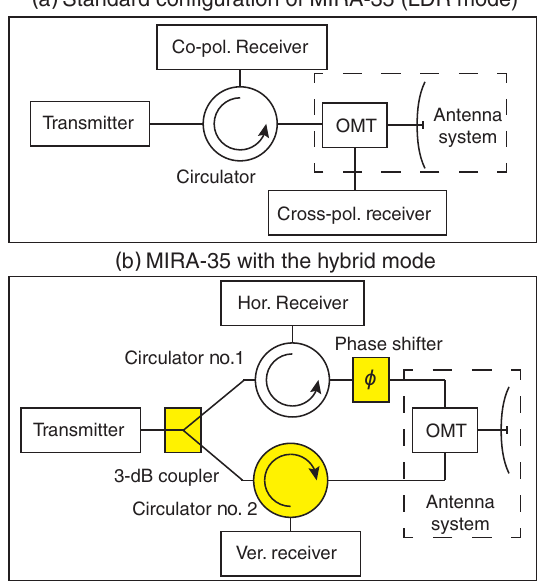
Figure 1. Simplified block diagrams of typical LDR (a) and hy- brid (b) modes of MIRA-35. Components, added for the implemen- tation of the hybrid mode from the LDR mode, are shown in yellow color. OMT is an orthomode transducer. See details in the